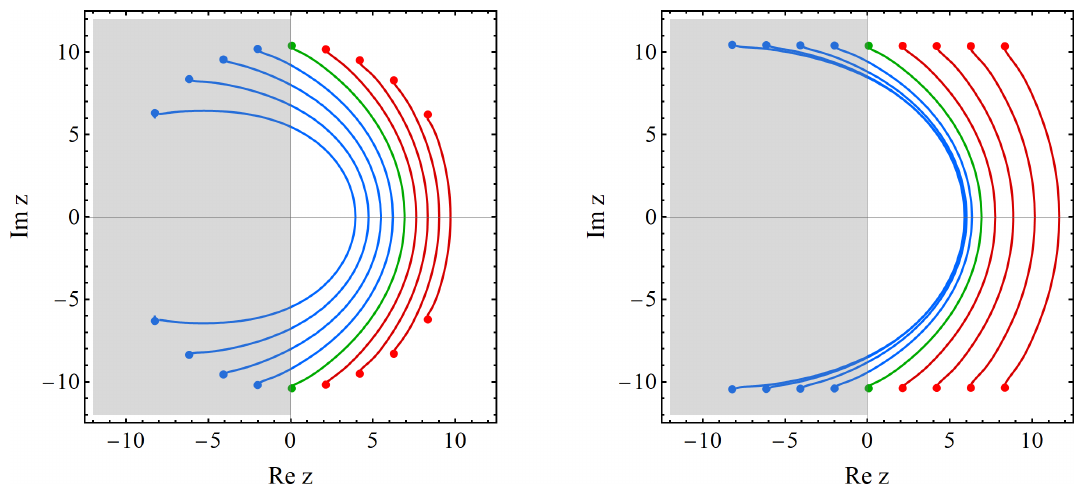
Figure 14 . The Stokes lines for spin-1 bosons (left panel) and spin-1/2 fermions (right panel) in dS with η -type deviation and η = 0 . 1 , c ( k ) = 0 . 05 . In both panels, the dimensionless chemical potential ranging over ˜ κ = − 8 , − 6 , · · · , 6 , 8 (from left to right, and the green lines correspond to the case without chemical potential), with spin-1 boson mass and spin-1/2 fermion mass µ = ˜ m = 10 . The gray region with Re z < 0 cannot be reached